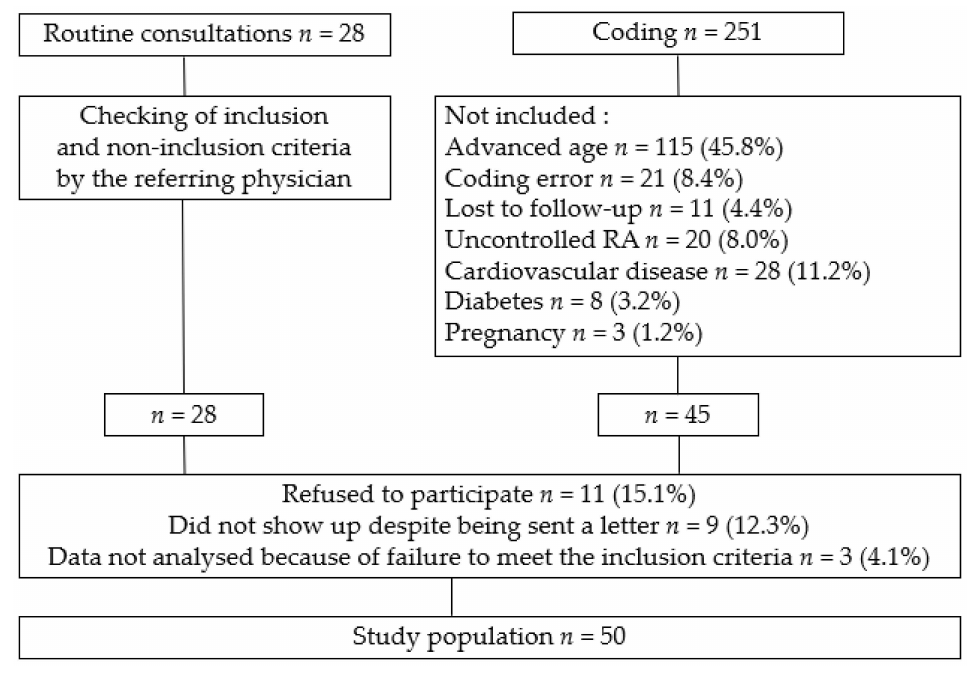
Figure 1. Flowchart. Table 1. Characteristics of the 50 rheumatoid arthritis patients at the start of the study